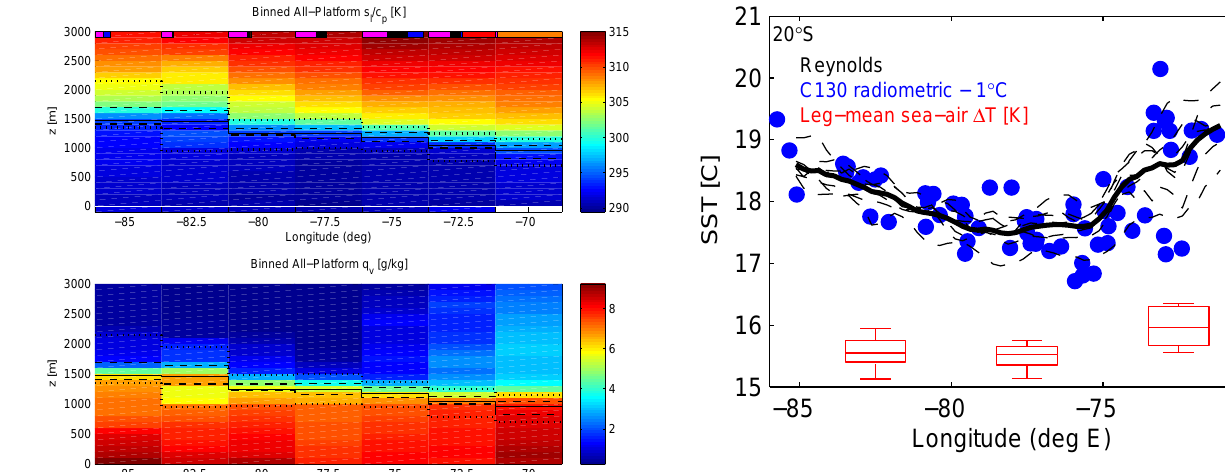
Fig. 6. Comparison of Reynolds SST along 20 ◦ S (black dash shows individual C130 flight days; solid black curve shows monthly mean) with C130 downward-looking radiometric temperature (blue dots) averaged over subcloud legs with a − 1K corrective offset added. The boxplot at the bottom shows a sea-air temperature difference 1T (red, scale at right) estimated from C130 subcloud legs as the difference of leg-mean corrected radiometric SST and in-situ s l /c p at approximately 145m altitude. In this and all following boxplots, the data ( 1T in this case) have been binned into three longitude ranges. Within each range, the plotted box extends vertically from the 25th to the 75th percentile of the data in that bin, with the median shown in the box interior, and the dashed “whiskers” extend out to the 10th and 90th